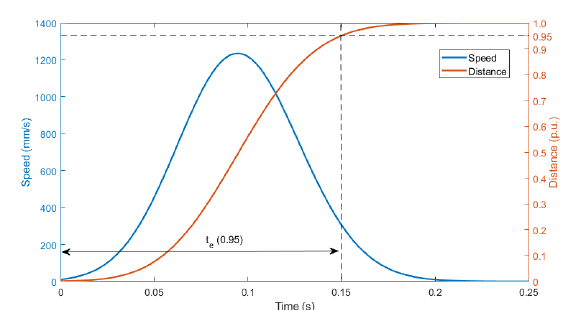
Figure 5. Procedure for calculating the parameter σ . The blue curve shows the lognormal speed profile, in which t 0 = 0 and µ = ln ( 1 ) . The red curve is the integral given by Equation (15), whose range is between zero, for t = 0 and one, for t = ∞ . It is observed that although the time to reach 1 is theoretically infinite, this value is reached much earlier than that. In the figure, this value is set at time t e to 0.95. Knowing the values of t 0 and of µ , the value of σ is calculated with iterative methods. For clarity, an r value of 0.95 was used in the explanations, but in the tests, an r value of 0.99 was